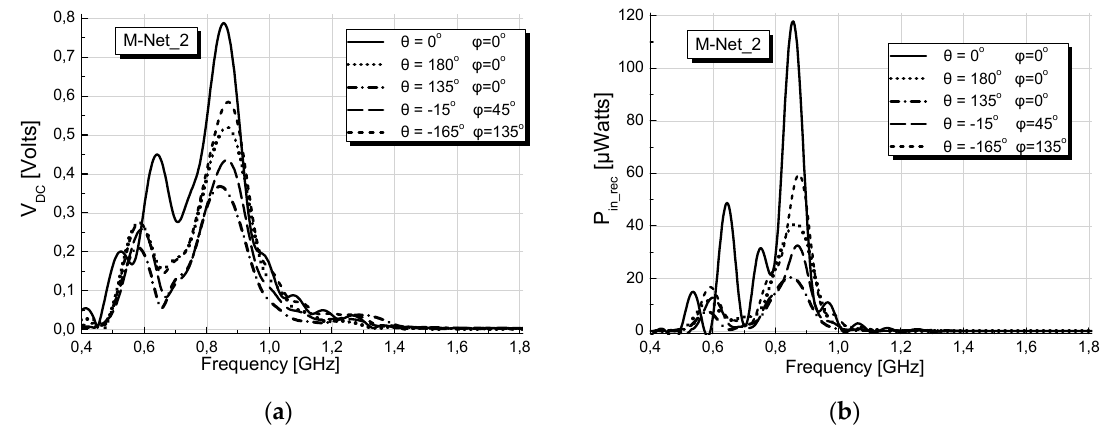
Figure 16. Results versus frequency when M-Net_2 is connected: ( a ) DC Voltage at the output of the rectifier (rec1) ( b ) power available at the input of the rectifier.